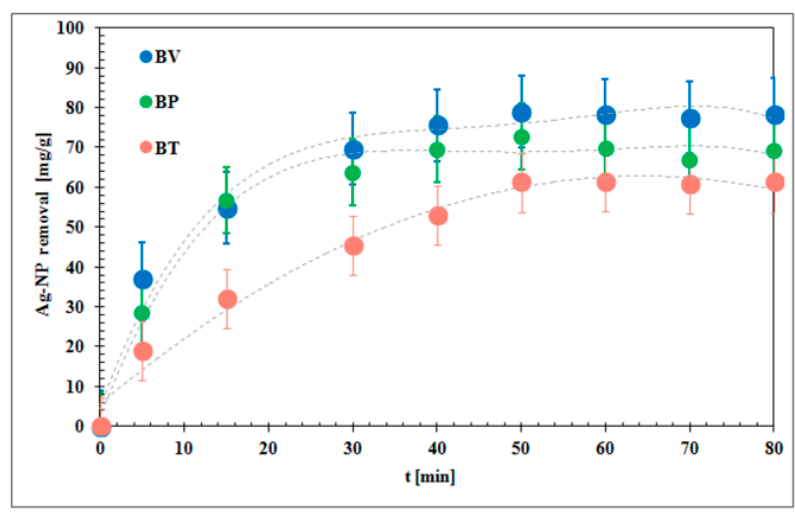
Figure 3. Pseudo-second order adsorption kinetics of Ag-NPs on biochars. Table2. KineticparametersofAg-NPadsorptiononbiochars( q e -Ag-NPremovalcapacityatequilibrium; k 1 , k 2 -reaction rate